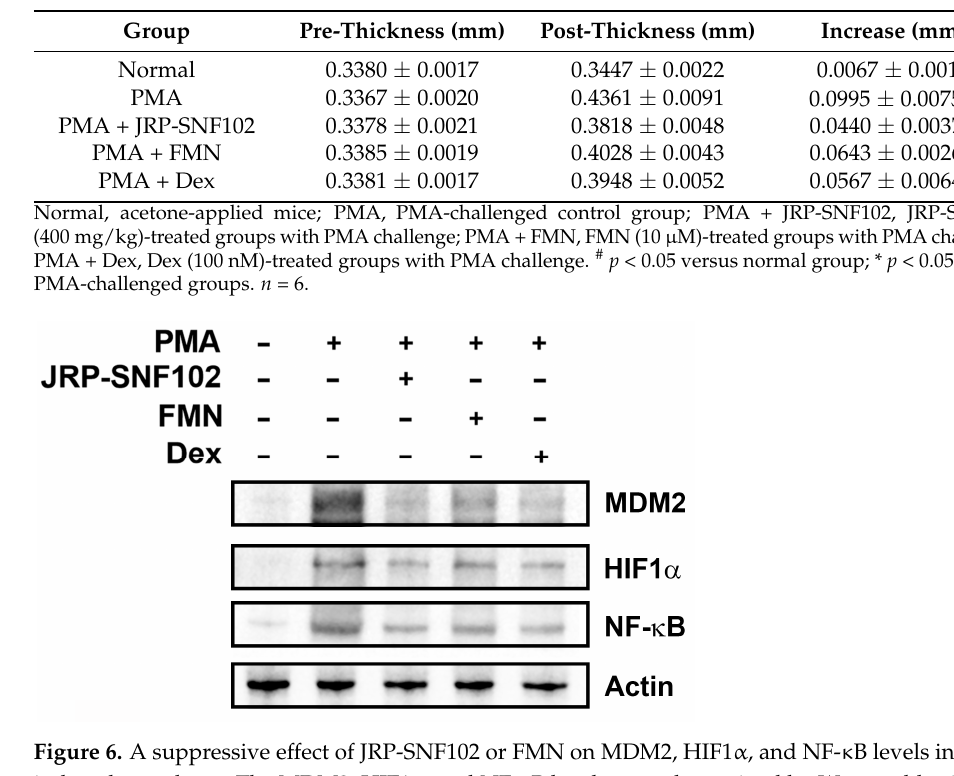
Figure 6. A suppressive effect of JRP-SNF102 or FMN on MDM2, HIF1 α , and NF- κ B levels in PMA- induced ear edema. The MDM2, HIF1 α , and NF- κ B levels were determined by Western blotting. -, non-treatment; +, treatment. Table 2. The increase of ear